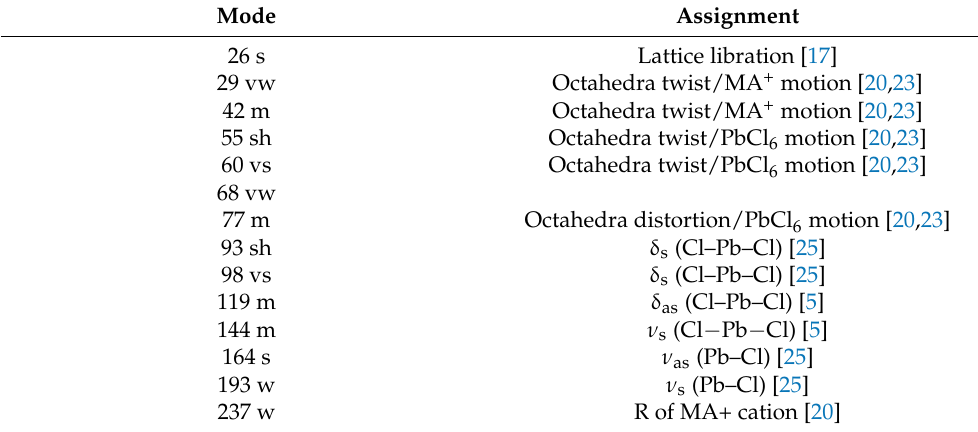
Table 2. Raman mode assignments of vibrational modes in the 10–3500 cm − 1 frequency range according to PbCl 6 octahedra and MA cation molecular symmetry. All the vibrational modes correspond to the orthorhombic phase Pnma